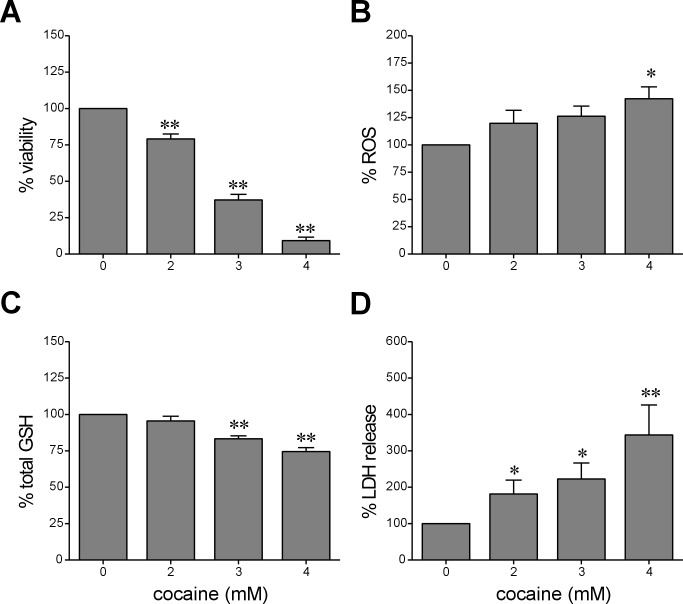
Measurement of the acute effects of cocaine exposure in astroglia-like cells on cell viability (A), ROS production (B), total GSH levels (C), and LDH release (D).Cells were treated with the indicated concentrations of cocaine for 1h. Cell viability was assessed using the crystal violet dye (0.1%) uptake protocol (n = 9). ROS production was assessed by loading cells with a H2DCFDA dye (10 μM, 30 min), followed by cocaine exposure in phenol red–free media. Dichlorodihydrofluorescein (DCF) was measured on a micro plate fluorometer with the excitation and emission filters set at 485 and 530 nm respectively (n = 4). Depletion in GSH levels were quantified on a plate reader following exposure to cocaine (n = 6). For measurements of LDH release, cells in phenol red–free media were treated with cocaine following which they were incubated in equal volumes of media and substrate from the assay kit (50 μl, 30 min) before being read on a micro plate reader (n = 12). Data for all measures are represented as mean ± S.E.M. (n = number of assays), *P<0.05; **P<0.001–0.01 w.r.t to control.